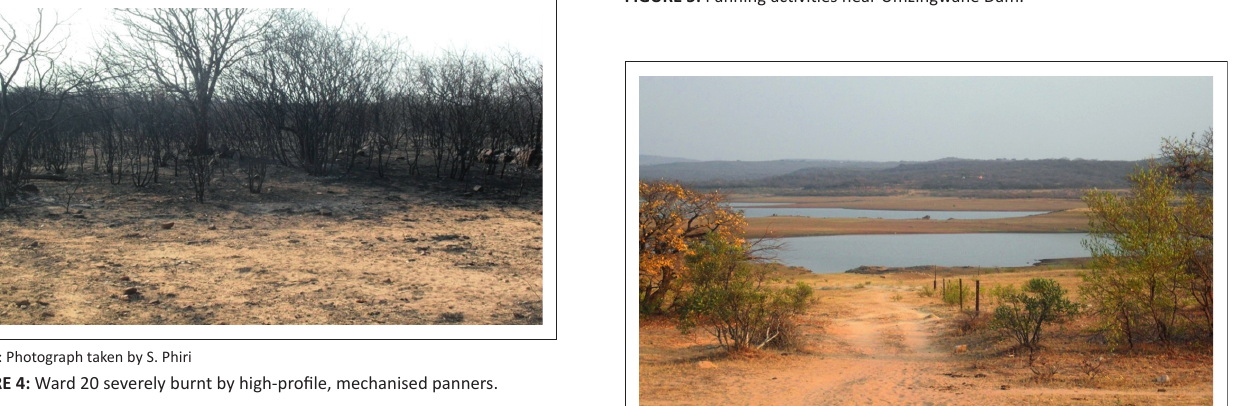
Source : Photograph taken by S. Phiri FIGURE 5: Panning activities near Umzingwane Dam.